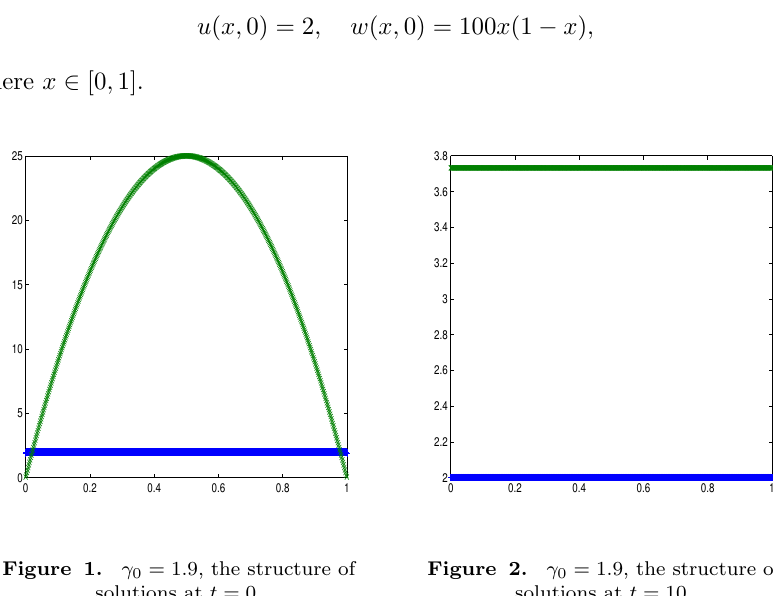
Figure 2. γ 0 = 1 . 9, the structure of solutions at t =